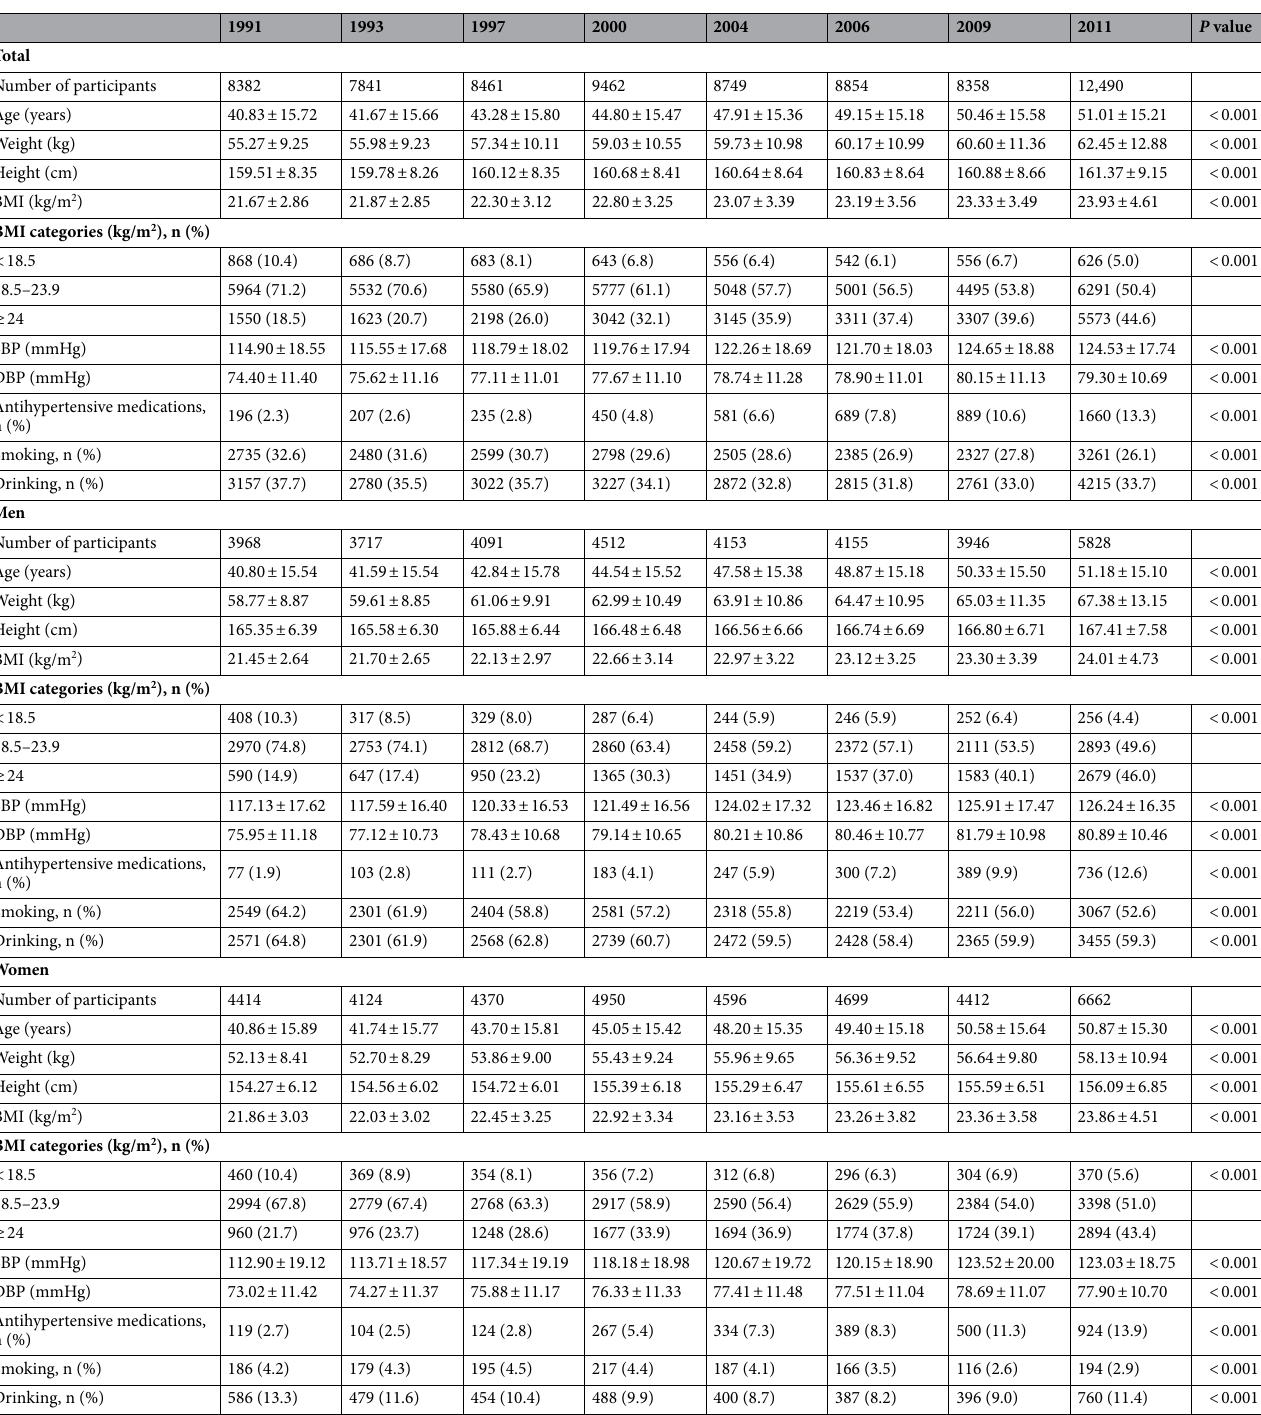
Table 1. Baseline characteristics of study participants. BMI Body mass index, SBP Systolic blood pressure, DBP Diastolic blood